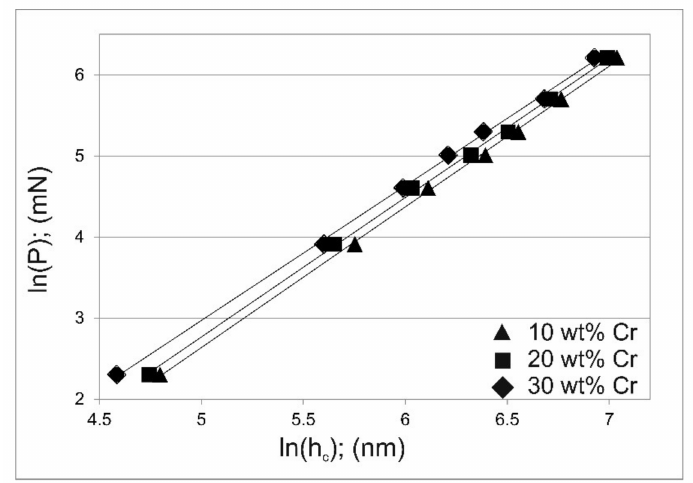
Figure 7. Dependence of the indentation load P on the contact depth of the indenter with the sample at maximum indentation load h c on a bilogarithmic scale according to Meyer’s law for the tested areas containing 10, 20 and 30 wt.% of